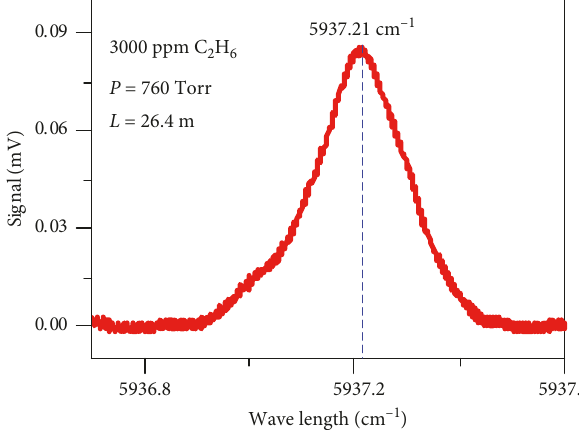
Figure 2: Direct absorption spectroscopy of C